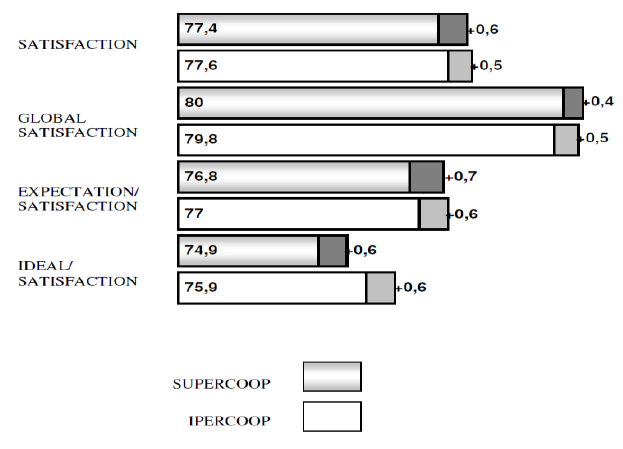
Figure 3. Customer Satisfaction Index 2002 and ∆ vs